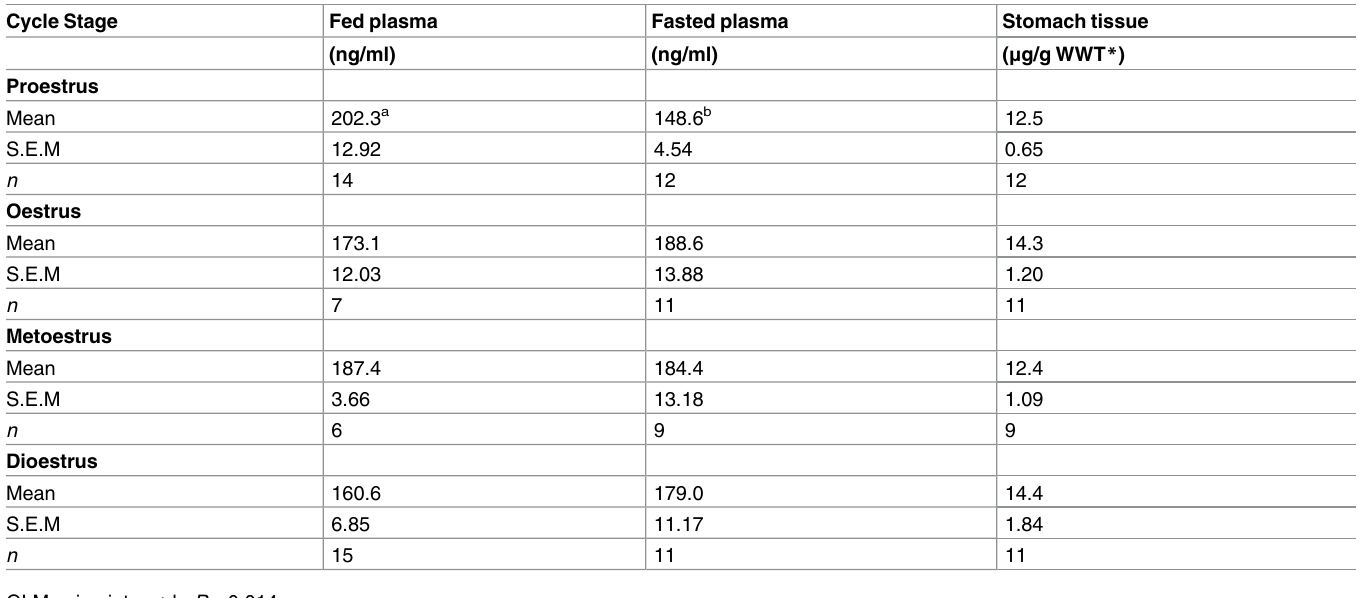
Table 1. Concentrations of ghrelin in fed and fasted plasma and in fasted stomach tissue during the oestrous cycle. Cycle Stage Fed plasma Fasted